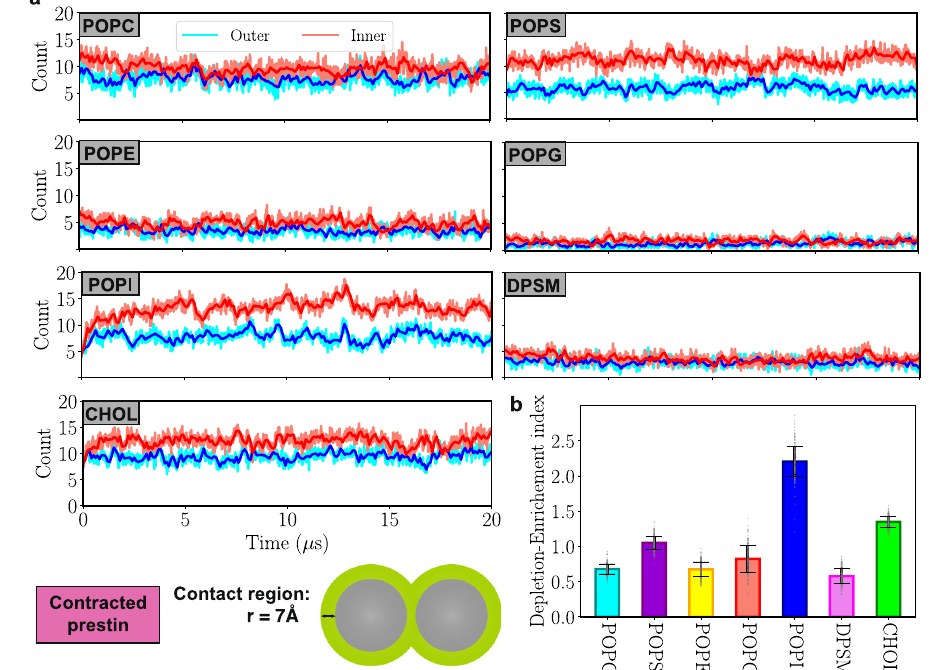
Fig. 6 | Enrichment/depletion of different lipids around contracted prestin. a Time series of the number of different lipid types within 7 Å of a prestin dimer, averaged over four dimers, in the outer (blue) and inner (red) lea fl ets. POPI lipids accumulate the most around prestin in the inner lea fl et. b Depletion-Enrichment index of each lipid type (the ratio of the local and bulk fractions of the lipid). POPI